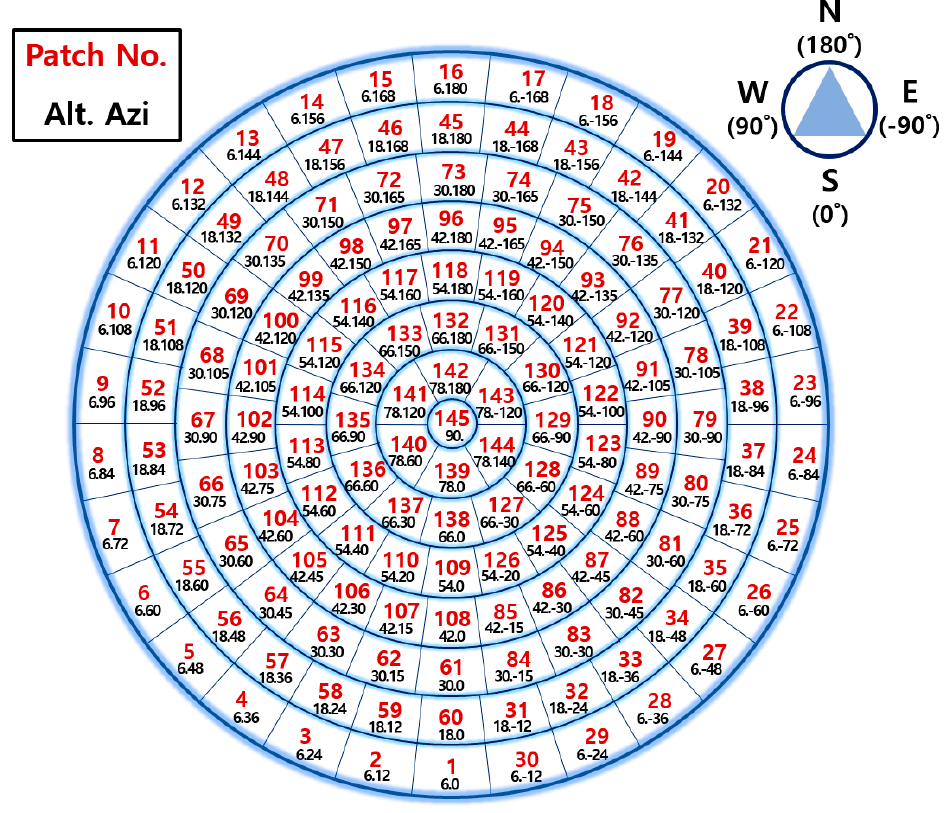
Figure 8. Calculation points for the sky patches.